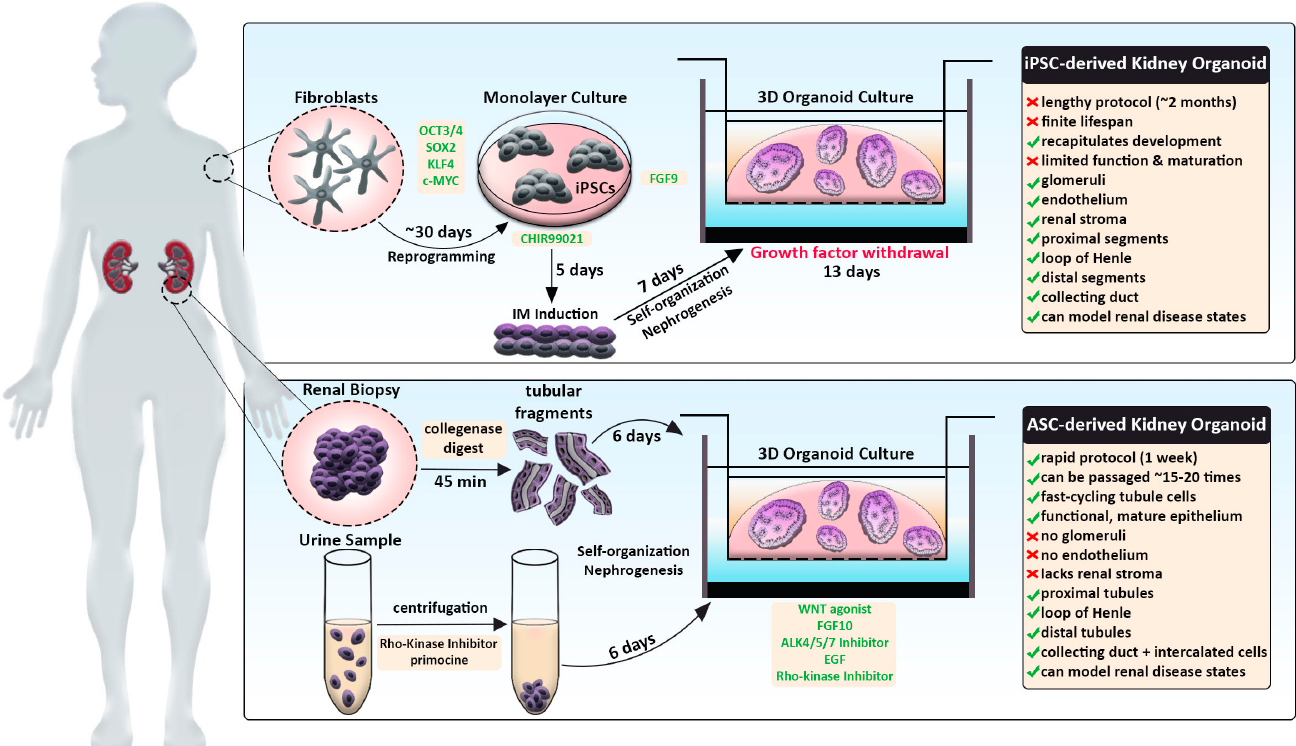
Figure 1. Schematic comparing human iPSC-derived and ASC-derived kidney organoid strategies. iPSC-derived kidney organoid protocol ( top ) typically entails reprogramming patient fibroblasts (grey), induction of IM in monolayer culture conditions and directed differentiation by timed addition of certain factors (green). This process is relatively lengthy but more accurately recapitulates processes taking place during embryonic kidney development. ASC-derived kidney organoid protocol ( bottom ), also termed ‘tubuloids,’ involves the isolation of renal cells via biopsy or urine sample (purple). Upon processing, tubular fragments or urine-derived cells are directly seeded into 3D culture conditions and treated with growth factors (green) to induce rapid differentiation of nephron tubule structures. Resulting tubuloids constitute mature epithelium, can be passaged many times, but lack certain kidney cell types. Both systems promote the 3D assembly of organoids by